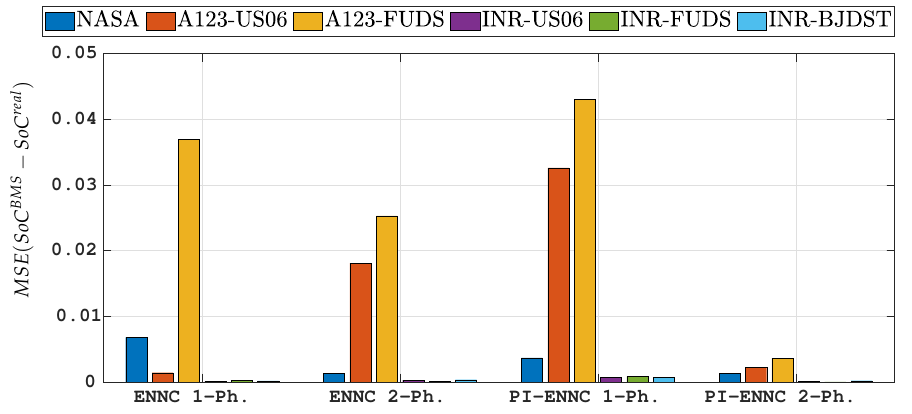
Figure 18. SoC MSE mean values considering results of Table 4 grouped per BMS prediction model and training